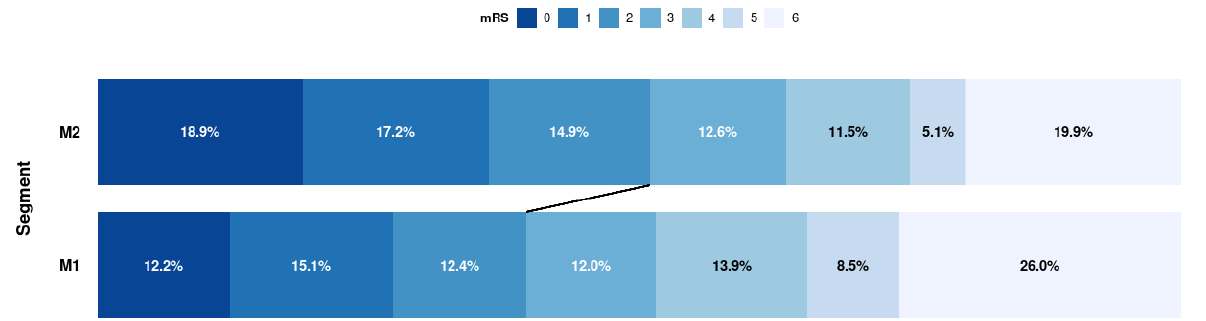
Figure 2. Flowchart of patient selection and exclusion criteria. Distribution of scores on the modified Rankin Scale (mRS) at 90 days. Shown is the shift in outcome within the study population (M1: n = 2689; M2: n = 1115). The numbers represent the percentage (rounded to first digit) of patients for a given outcome and group.